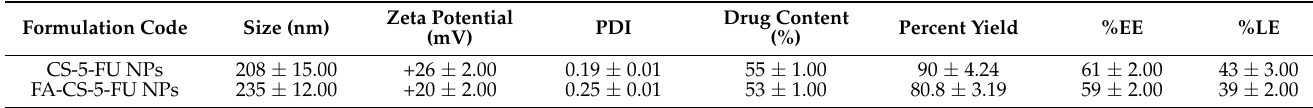
Table 1. Physicochemical characterization of folic-acid-modified 5-FU-loaded chitosan NPs. Data were presented as triplicate ( n = 3) and mean ±